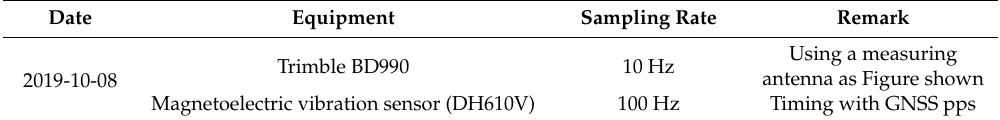
Figure 10. Experimental environment and equipment placement. Table 1. Device and data information.